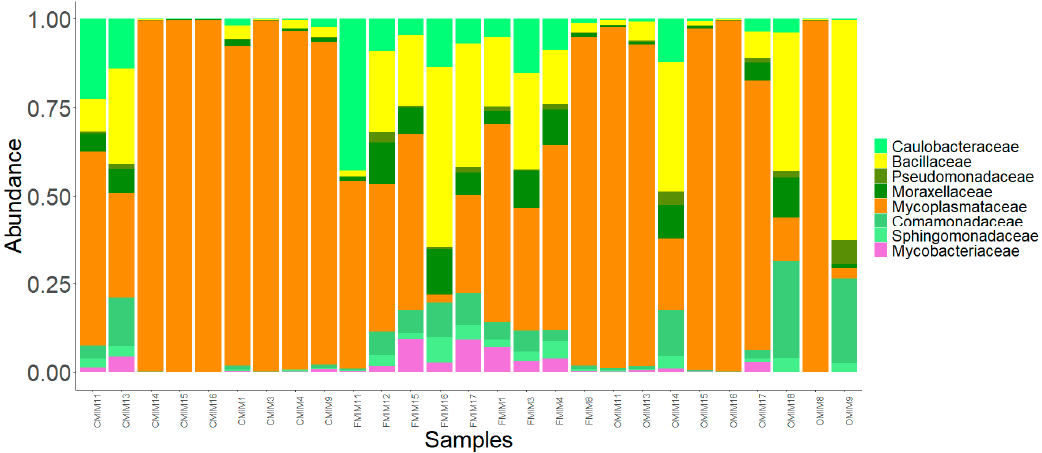
Figure 6. The core bacterial family in the mid intestine mucus of the three fish groups. Color codes: shades of green—families of Proteobacteria, yellow—families of Firmicutes, purple—families of Actinobacteria, and dark orange—families of Tenericutes.